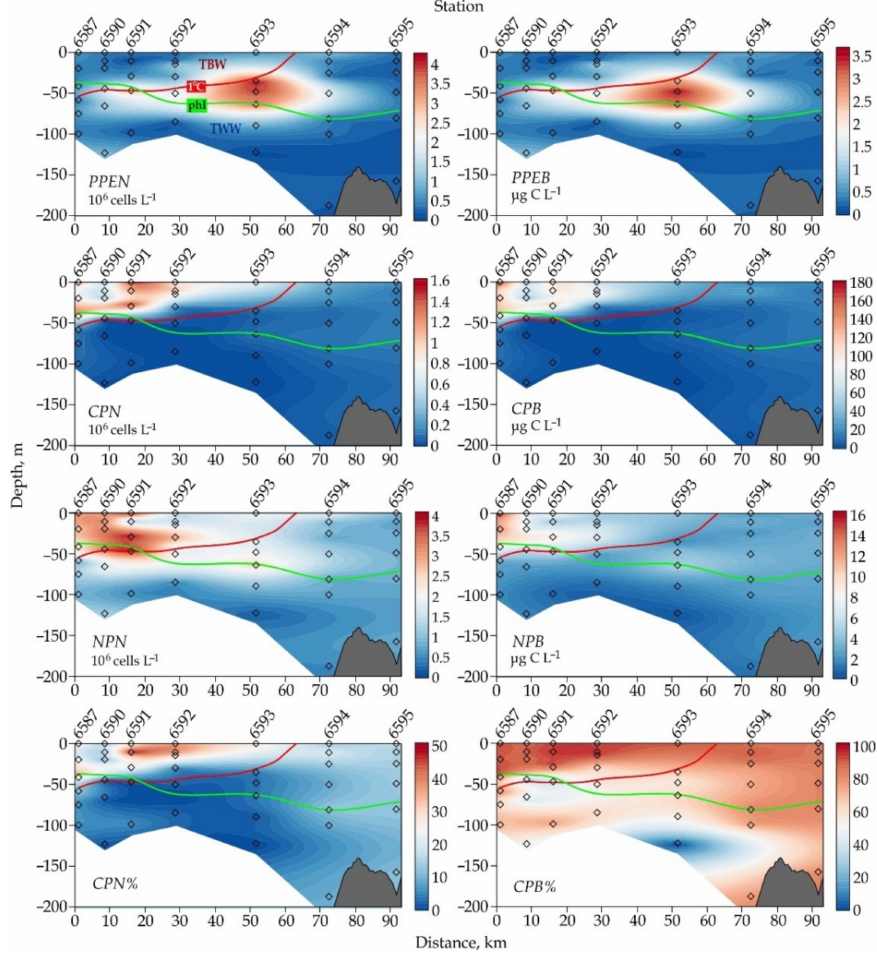
Figure 5. Vertical distribution of photosynthetic picoeukaryote ( PPEN , PPEB ), cryptophytes ( CPN , CPB , CPN% , CPB% ), and other nanophytoplankton ( NPN, NPB ) along the transect in the Bransfield Strait during austral mid-summer, January 2020. Green and red lines represent the bottom of the euphotic layer (phl) and 1 ◦ C isotherm (as a boundary between TBW and TWW; explanations are in the text), respectively. Description of the variables is in Table